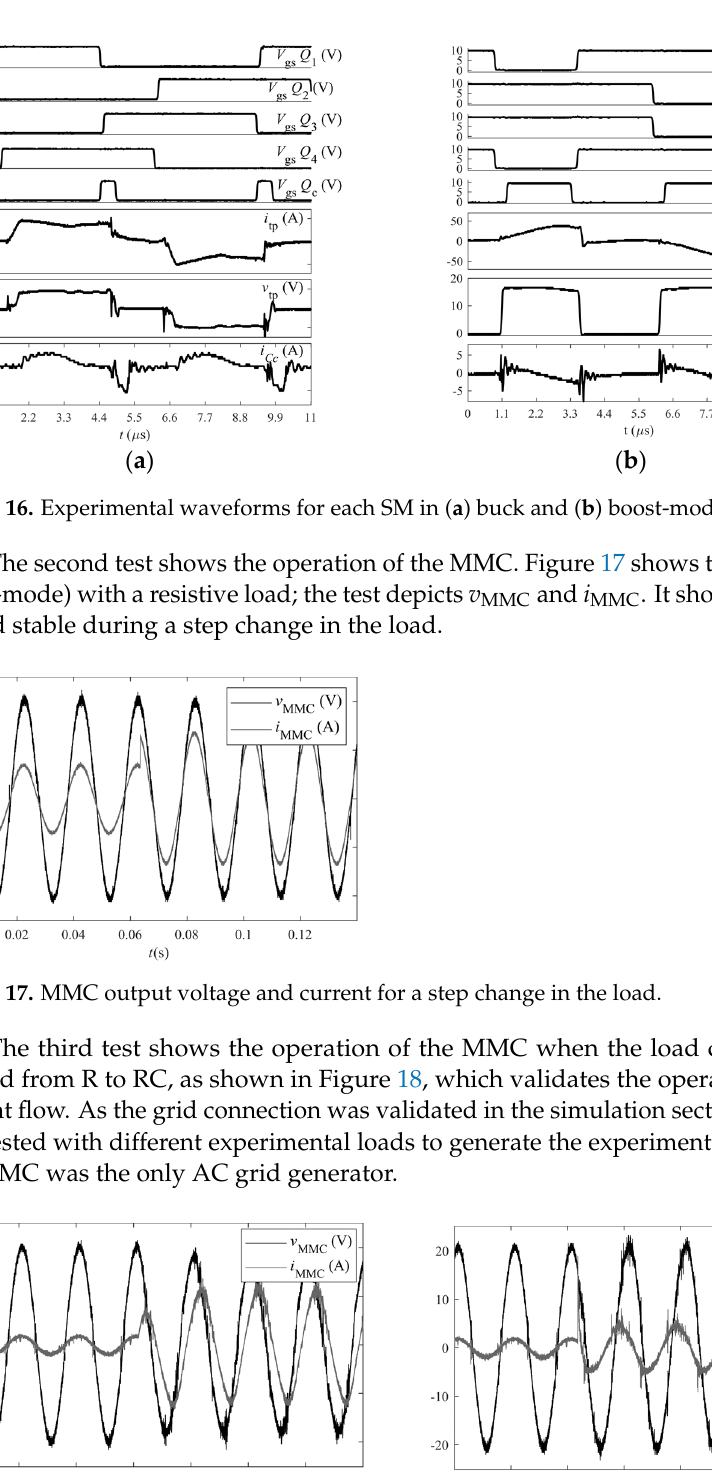
Figure 18. Step response from ( a ) R to RL and ( b ) R to RC.